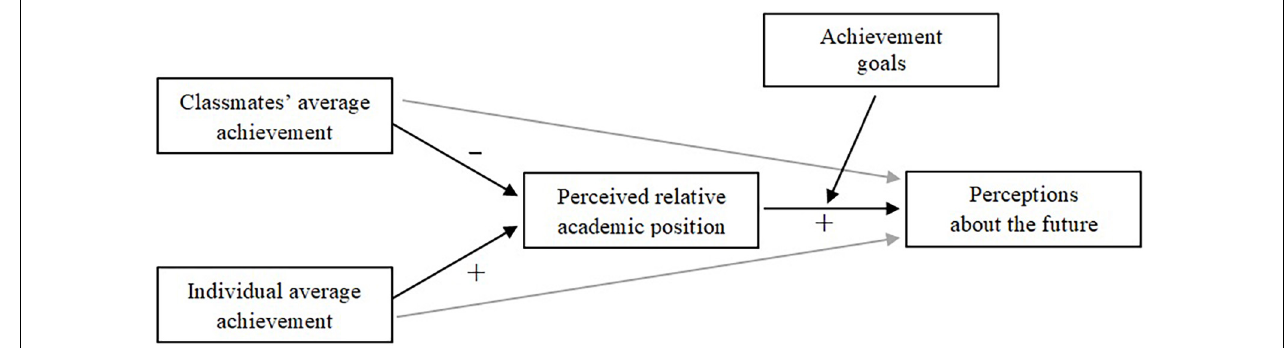
FIGURE 1 | Research